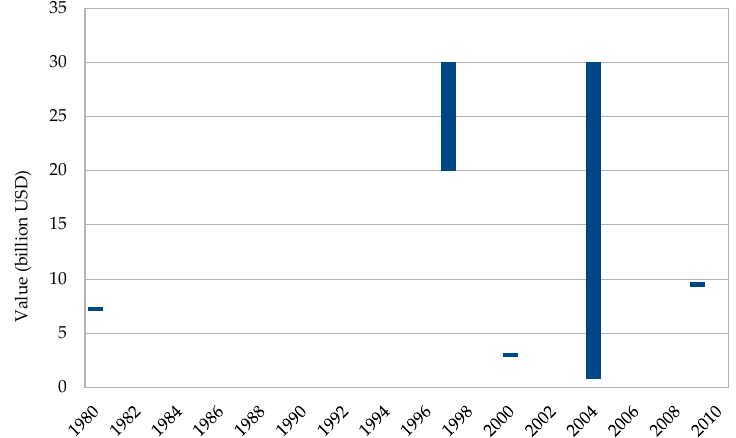
Figure 2. Global minimum and maximum value in billion USD of the freshwater and freshwater ornamental fish trade including accessories from 1980 to 2009 [7,16,28 – 36].